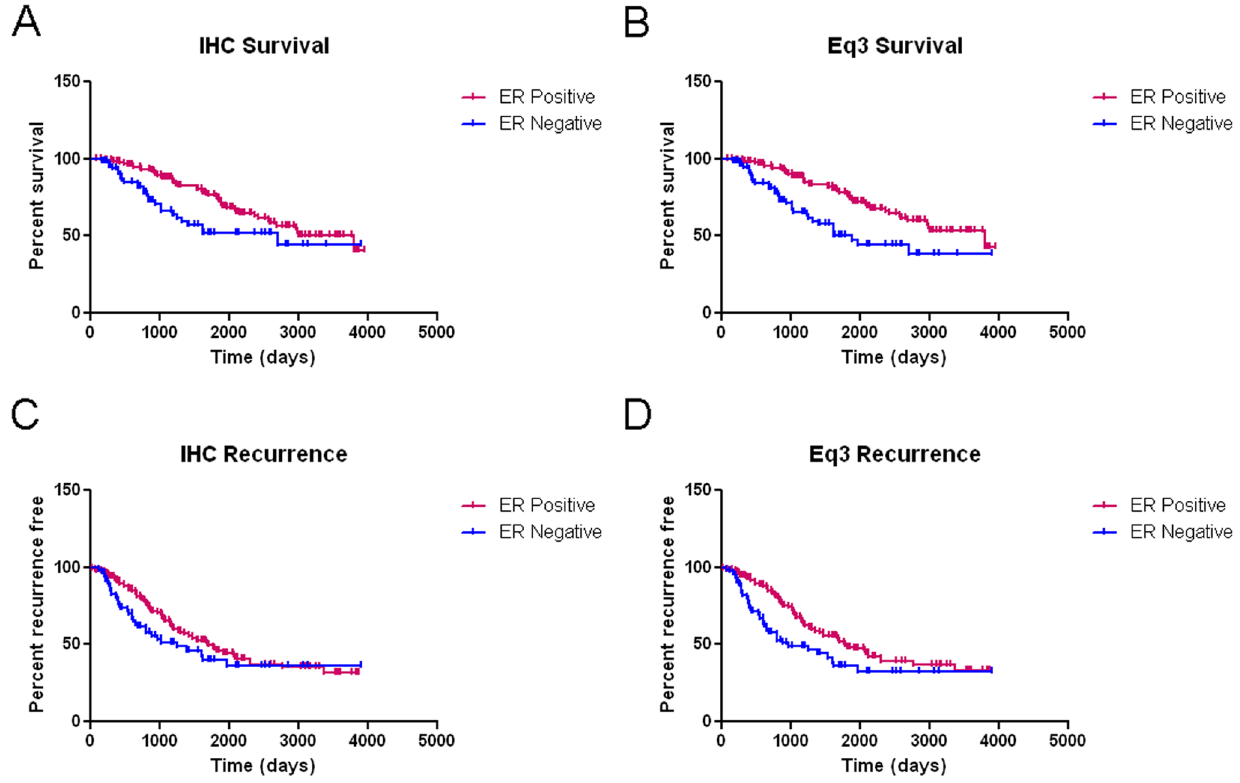
Figure 5. Kaplan-Meier Survival and Recurrence-Free Survival Curves For Patients Sorted by IHC-Determined ER-Status and Eq3 Predicted ER-Status. Both the survival and recurrence-free survival curves had greater separation and lower hazard ratios (HR) when the patients were sorted by Eq3 ER-status compared with traditional IHC. a) Survival curves for patients split based on IHC ER-status (ER + n=126, median survival=3807days; ER- n=72, median survival=2704days; HR=0.5090; 95% CI=0.2968–0.8731). b) Survival curves for patients split based on Eq3 ER-status (ER + n=123, median survival=3807days; ER- n=75, median survival=1623days; HR=0.3901; 95% CI=0.2420–0.6935). c) Recurrence-free survival curves for patients split based on IHC ER-status (ER + n=126, median recurrence-free survival=1694days; ER- n=72, median recurrence-free survival=1246days; HR=0.7160; 95% CI=0.4623–1.109).d) Recurrence-free survival curves for patients split based on Eq3 ER-status (ER + n=123, median recurrence-free survival=1820days; ER- n=75, median recurrence-free survival=875days; HR=0.5731; 95%